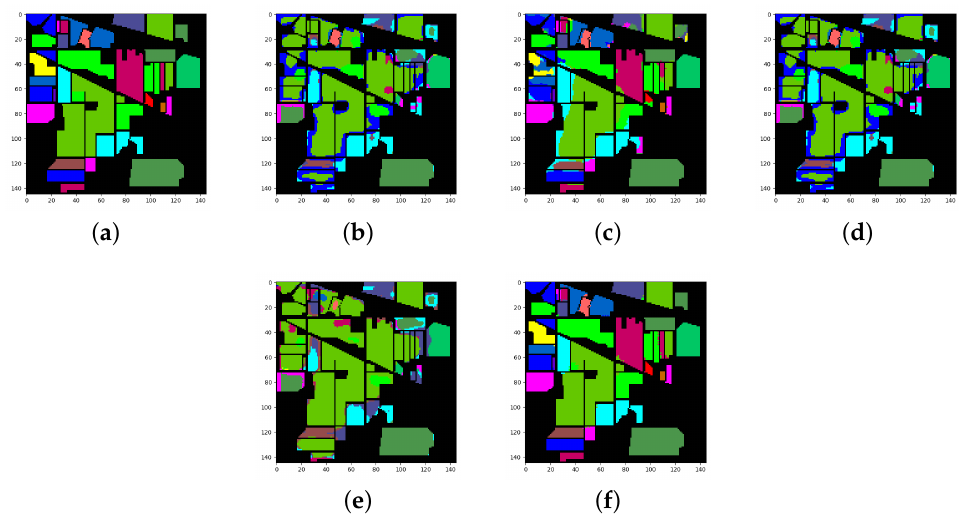
Figure 5. Classification maps for the IP dataset: ( a ) ground truth (GT); ( b – f ) results from the different algorithms. ( a ) GT; ( b ) SSRN; ( c ) FDSSC; ( d ) DBMA; ( e ) DBDA; ( f )